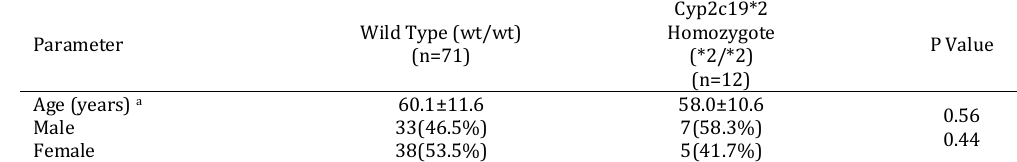
Table 2. Demographic data according to Genotype